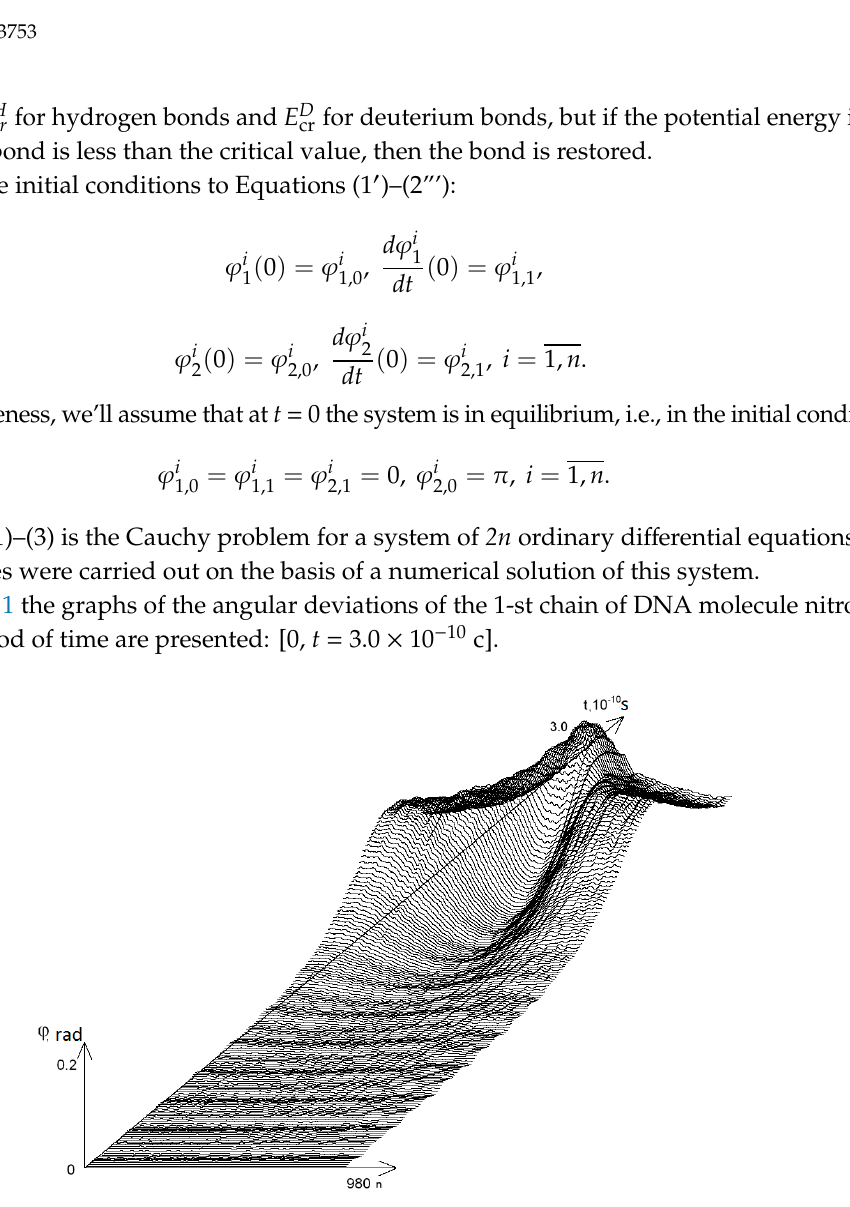
Figure 1. Graphs of angular deviations of the 1-st chain of DNA molecule nitrogenous bases over period of time: [0, t = 3.0 × 10 − 10 c].